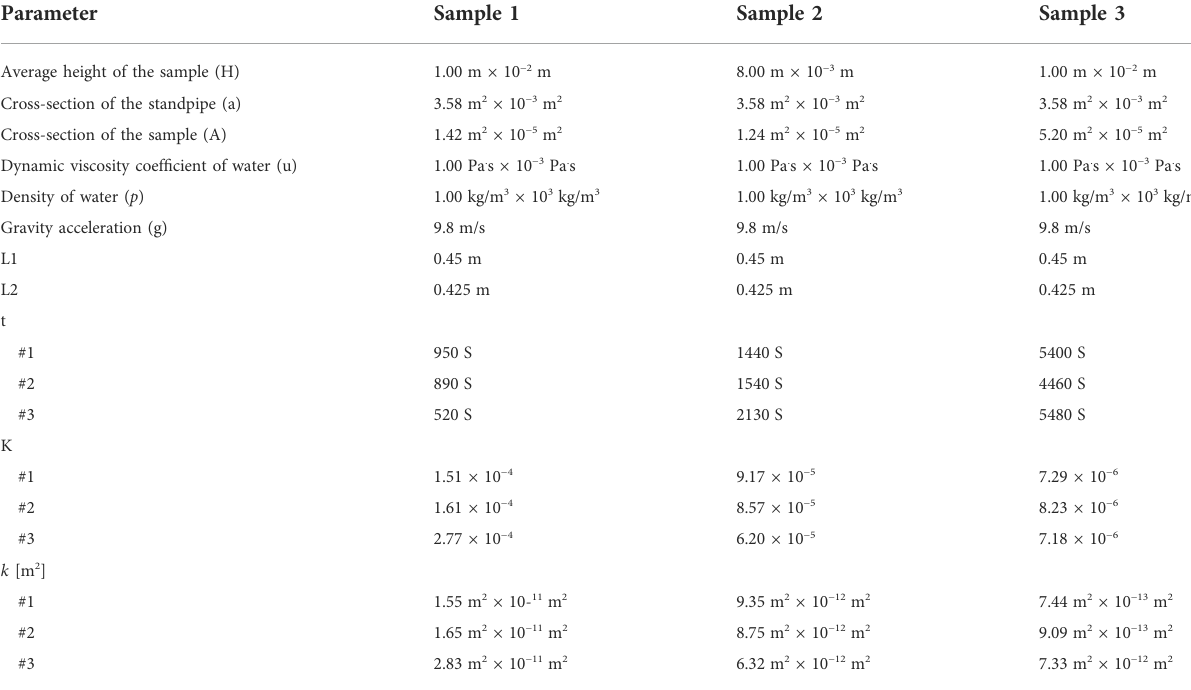
TABLE 5 Parameters and their values used in the permeability tests of the three